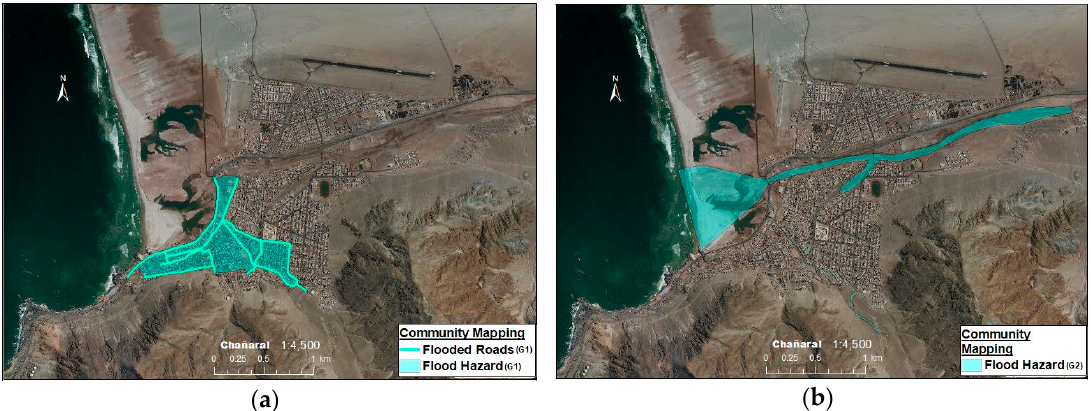
Figure 11. Flood risk perception in Chañaral: ( a ) Group 1, ( b ) Group 2.